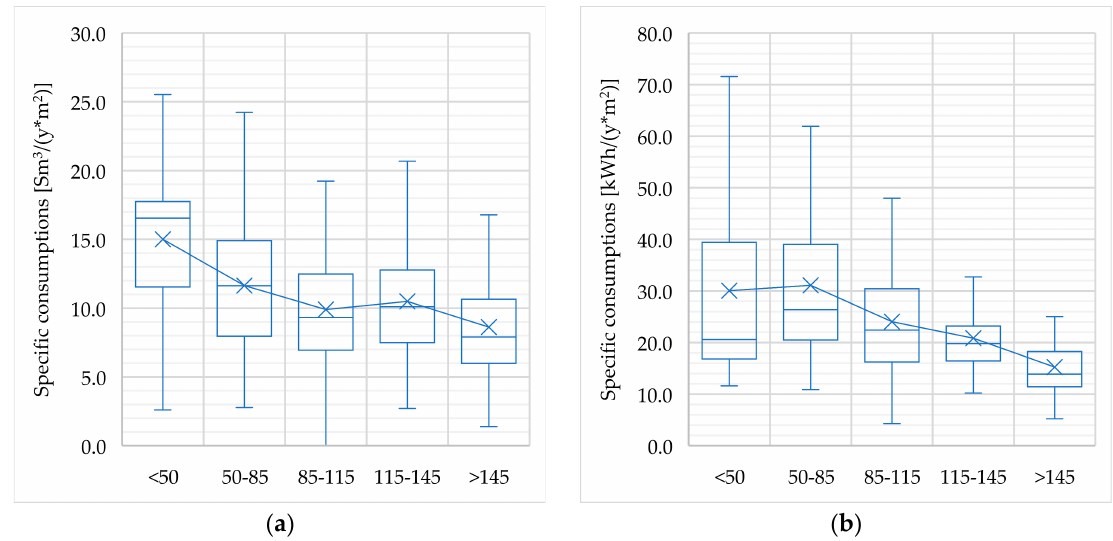
Figure 6. Specific consumptions by unit of surface vs. dwelling size: ( a ) Natural Gas; ( b ) Electricity.